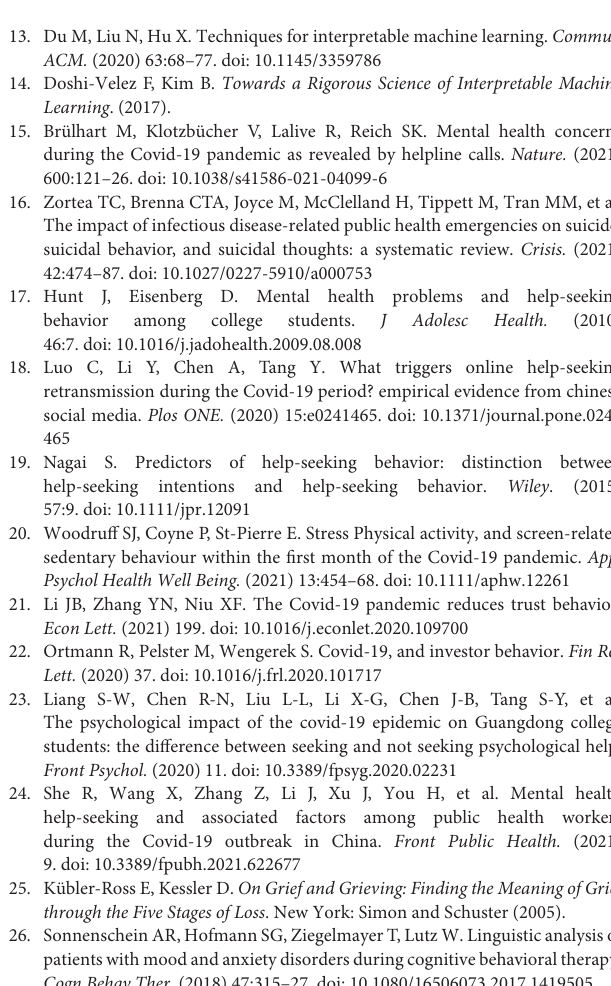
Supplementary Figure 1 | Silhouette Coefficient for K-Means model with different number of clusters. Supplementary Table 1 | Results of 10-fold cross-validation (Random Forest). Supplementary Table 2 | Details of